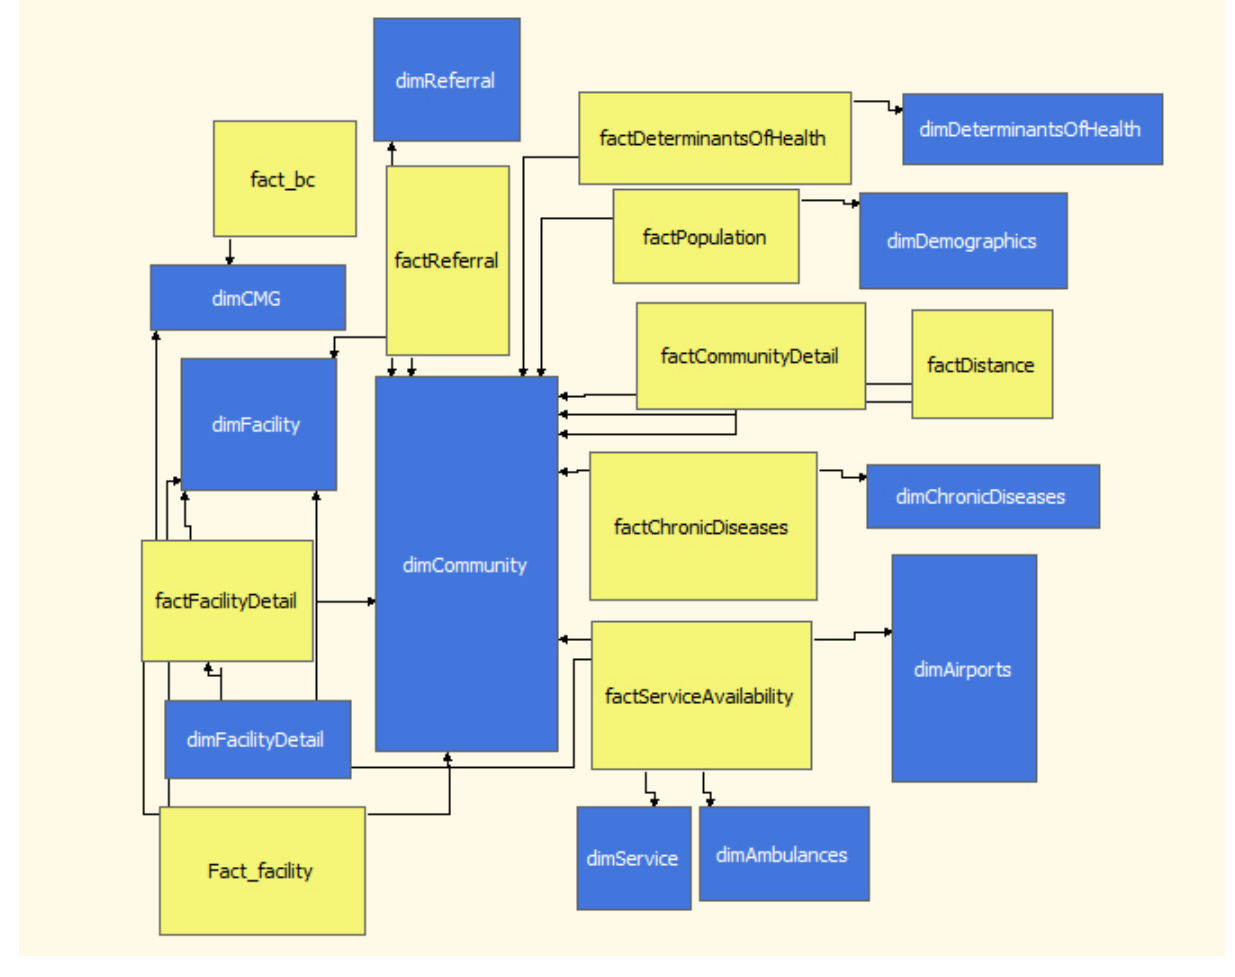
Figure 2. The Online Analytical Processing (OLAP)